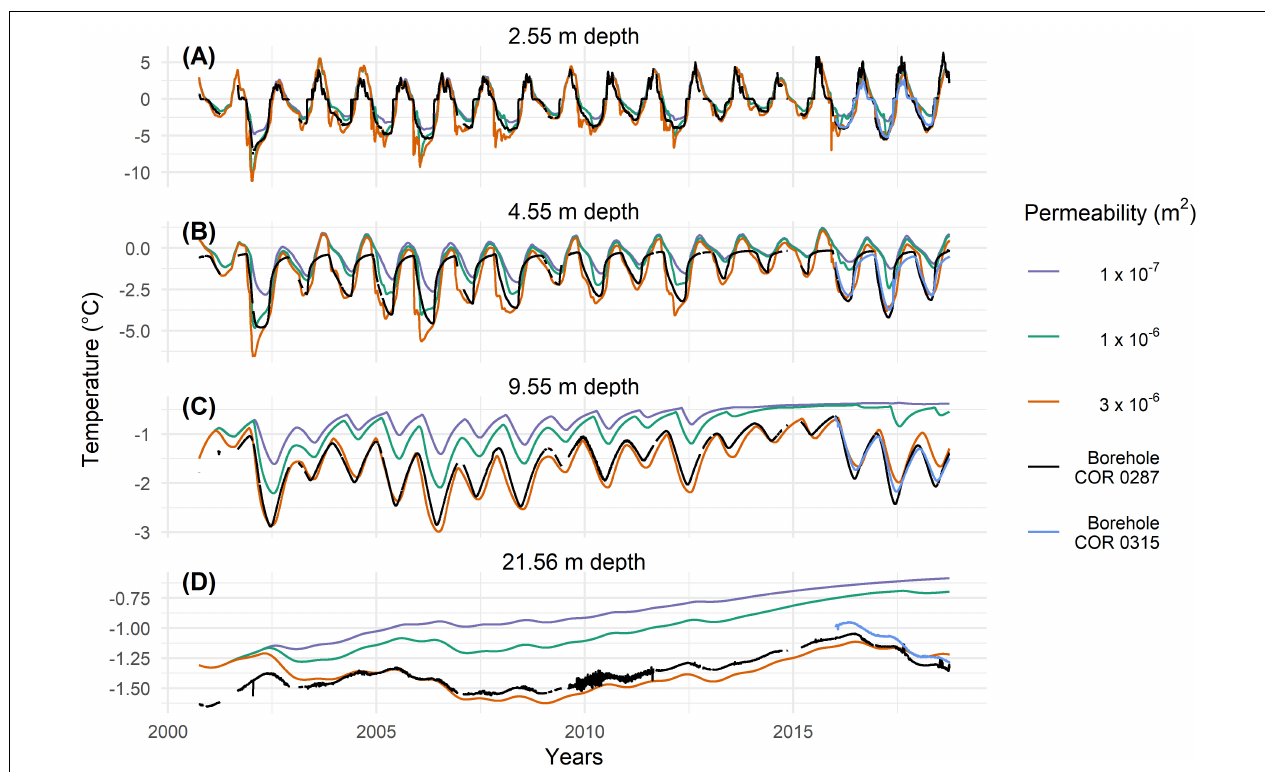
FIGURE 3 | Modeled temperatures at COR for different permeability at different depths of 2.55 m (A) , 4.55 m (B) , 9.55 m (C) , and 21.56 m (D) in a virtual borehole in the middle of the model domain (see Figure 1 ). Measured temperatures in the borehole are shown in black for the COR0287 borehole and blue for the COR0315 borehole (only from 2015